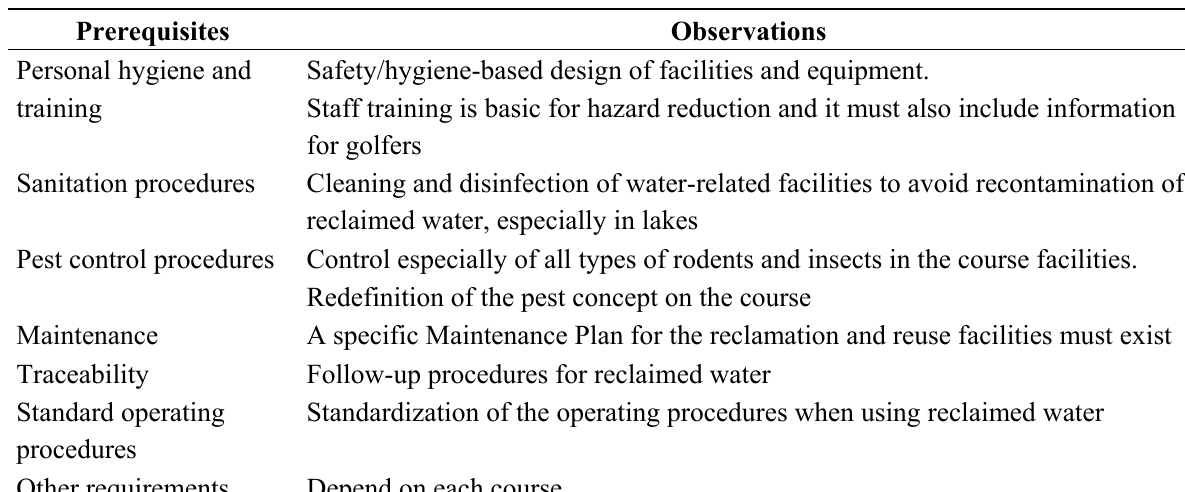
Table 14. Main prerequisites for the development of HACCP systems: Application to golf